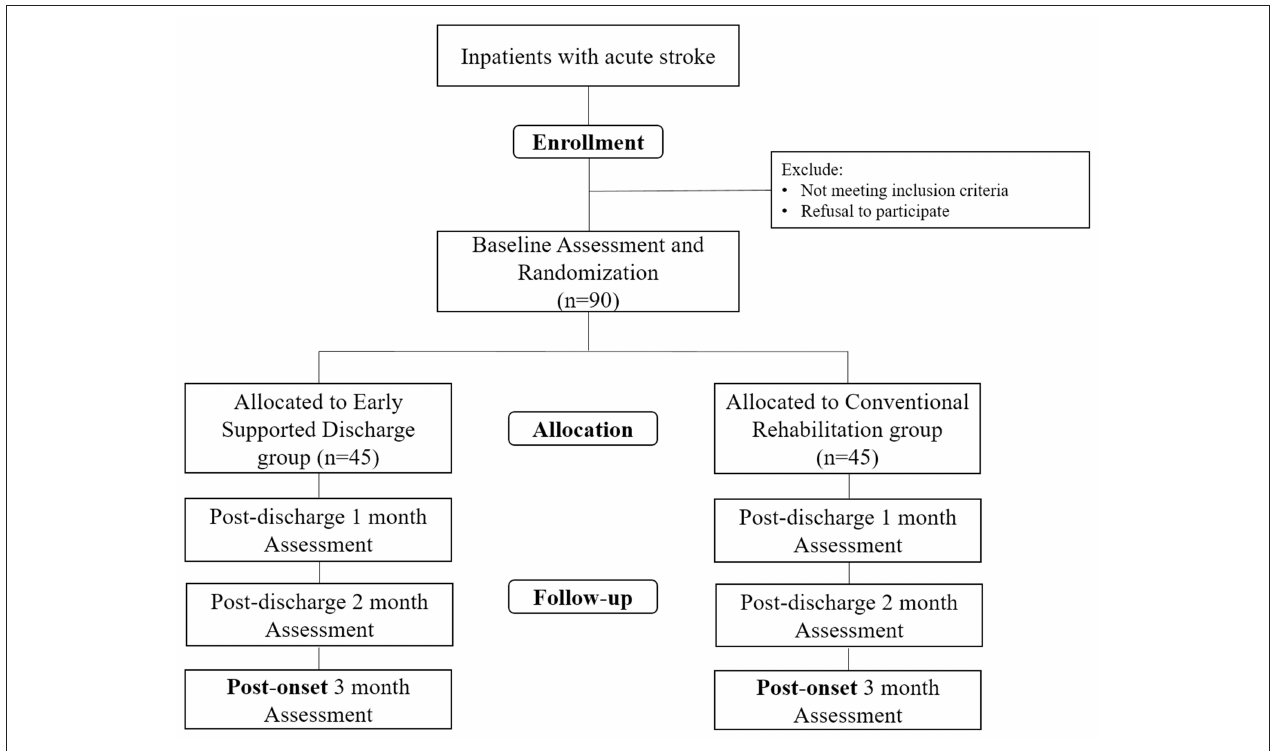
FIGURE 1 | Flowchart of the study design.